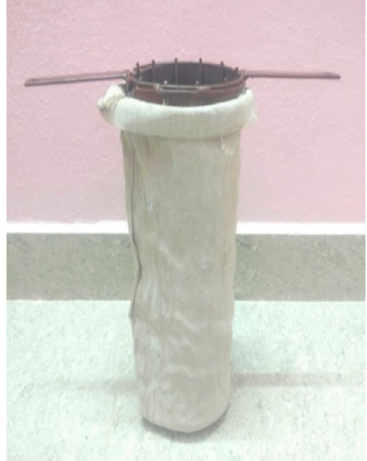
Figure 3. Zinc oxide-coated sisal fiber-based filter media.